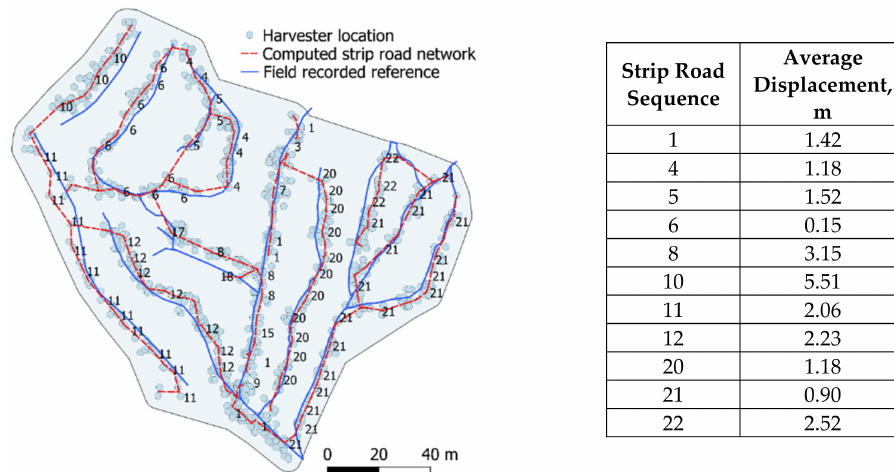
Figure 7. An example of systematic displacements in strip road sequences at one harvested stand. The strip road sequences are indicated by the numbers. At strip road sequence number 10, a clear local displacement is observed. The displacement values are given in the table for those strip road sequences for which the averaging could be performed (minimum of five observations were